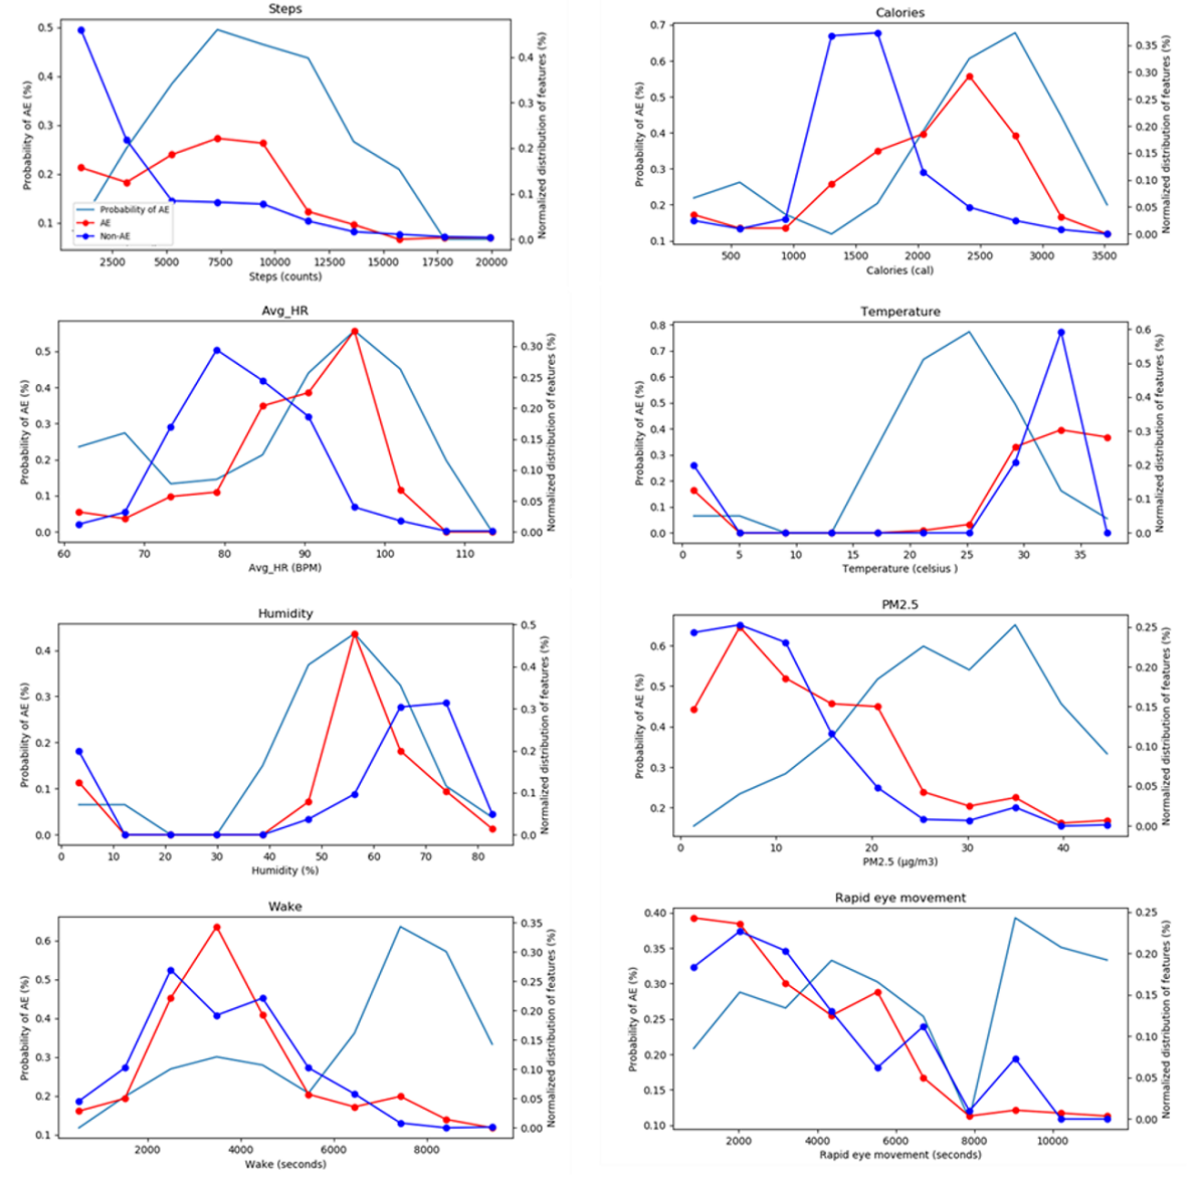
Table 3 and Figure 12 demonstrate the performance of the implemented models. The DNN model yielded the best performance with 6 metrics higher than 90%.